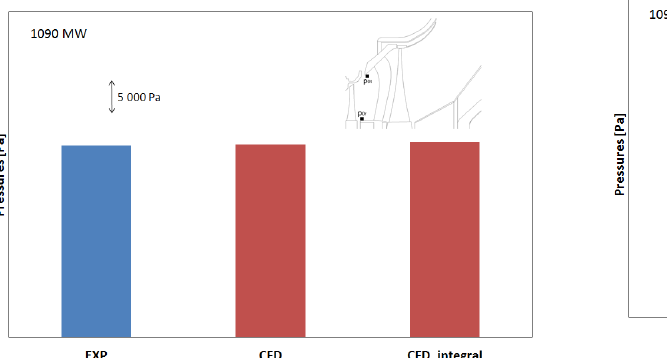
Figure 9. Static pressures in Plane 2.